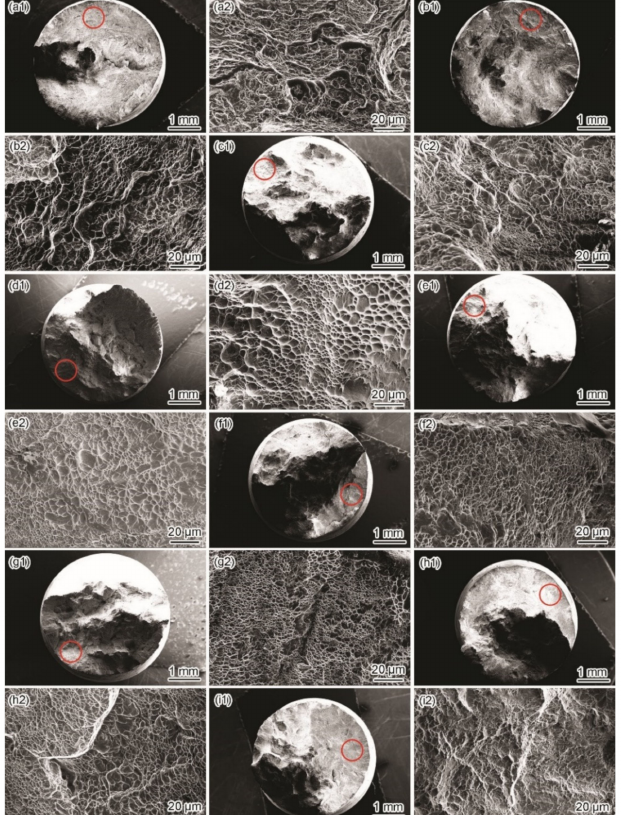
Figure 7. Fracture surface morphologies in a simulated deep–sea environment. Macromorphology of fracture surface at − 1.3 V ( a1 ), − 1 V ( b1 ), − 0.9 V ( c1 ), − 0.8 V ( d1 ), − 0.46 V ( e1 ), E corr ( f1 ), 0.1 V ( g1 ), 0.8 V ( h1 ), and 1.5 V ( i1 ); micromorphology at crack initiation site marked with red circle in ( a1 – i1 ) at − 1.3 V